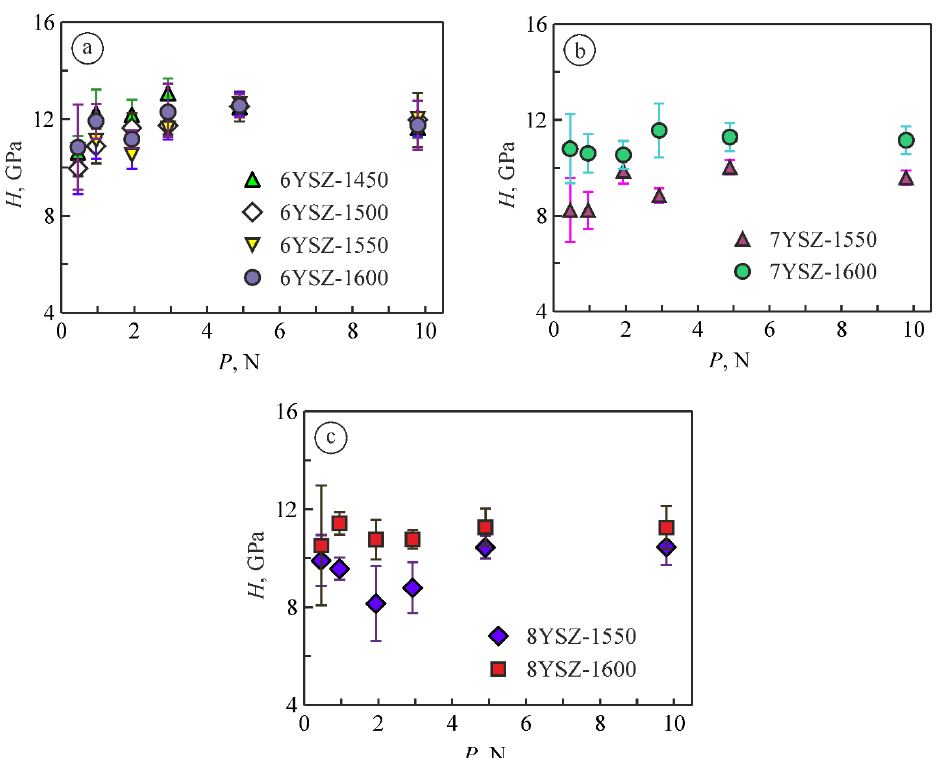
Figure 3. Dependences of microhardness on the indentation load for ( a ) 6YSZ, ( b ) 7YSZ, and ( c ) 8YSZ ceramics sintered at a temperature of 1450 °C (variant 6YSZ ‐ 1450), 1500 °C (variant 6YSZ ‐ 1500), 1550 °C (variants 6YSZ ‐ 1550, 7YSZ ‐ 1550, and 8YSZ ‐ 1550), and 1600 °C (variants 6YSZ ‐ 1600, 7YSZ ‐ 1600, and 8YSZ ‐ 1600). The variant numbers (see Table 1) correspond to the symbol numbers.